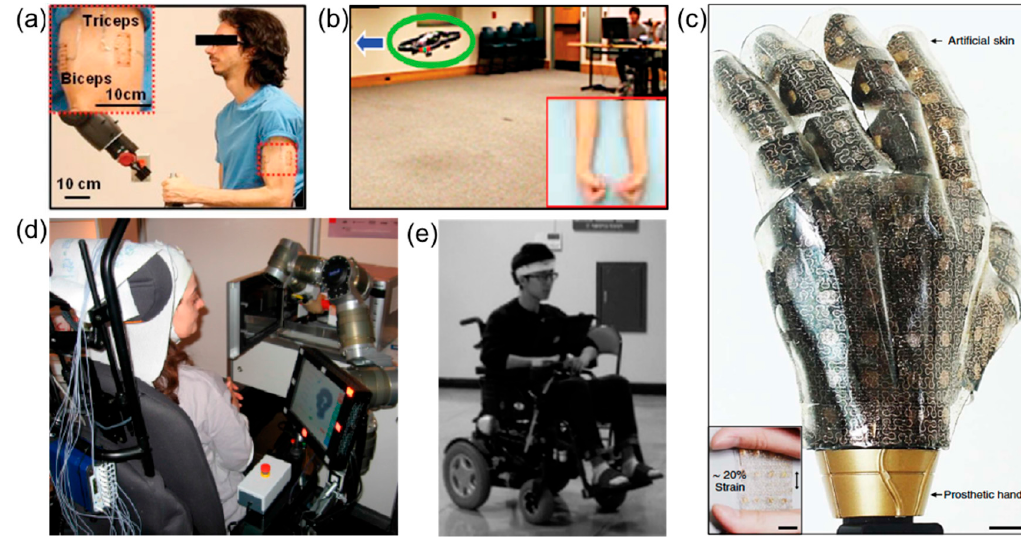
Figure 6. Flexible hybrid electronics for applications in human-machine interfaces. ( a ) EMG-enabled control of a humanoid